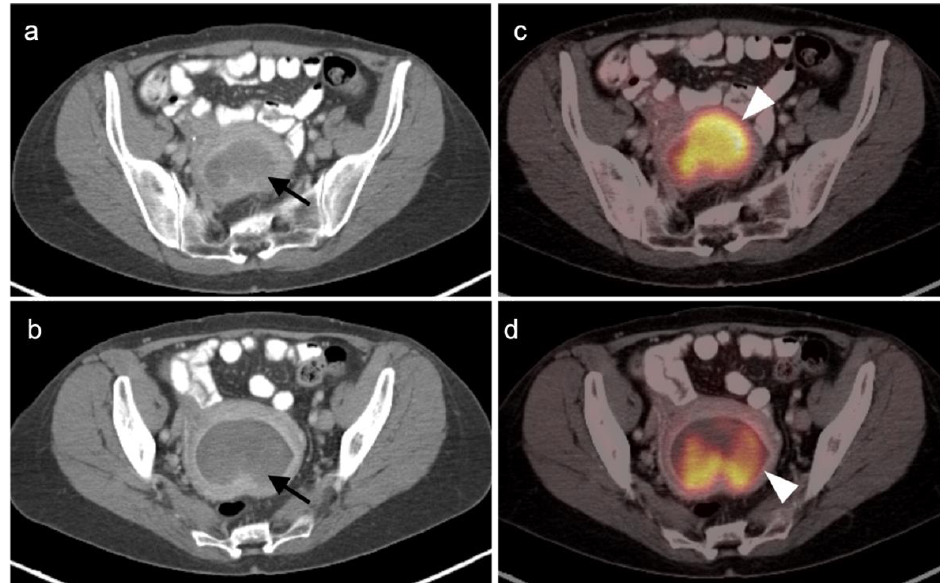
Figure 12. Endometrial carcinoma show on axial FDG PET-CT images of the pelvis. ( a , b ) Axial contrast-enhanced CT images of the pelvis show an endometrial mass that is very low in attenuation (black arrows). ( c , d ) Although low in attenuation, the mass is intensely hypermetabolic on FDG PET-CT (white arrowheads) and is typical in appearance for endometrial carcinoma.